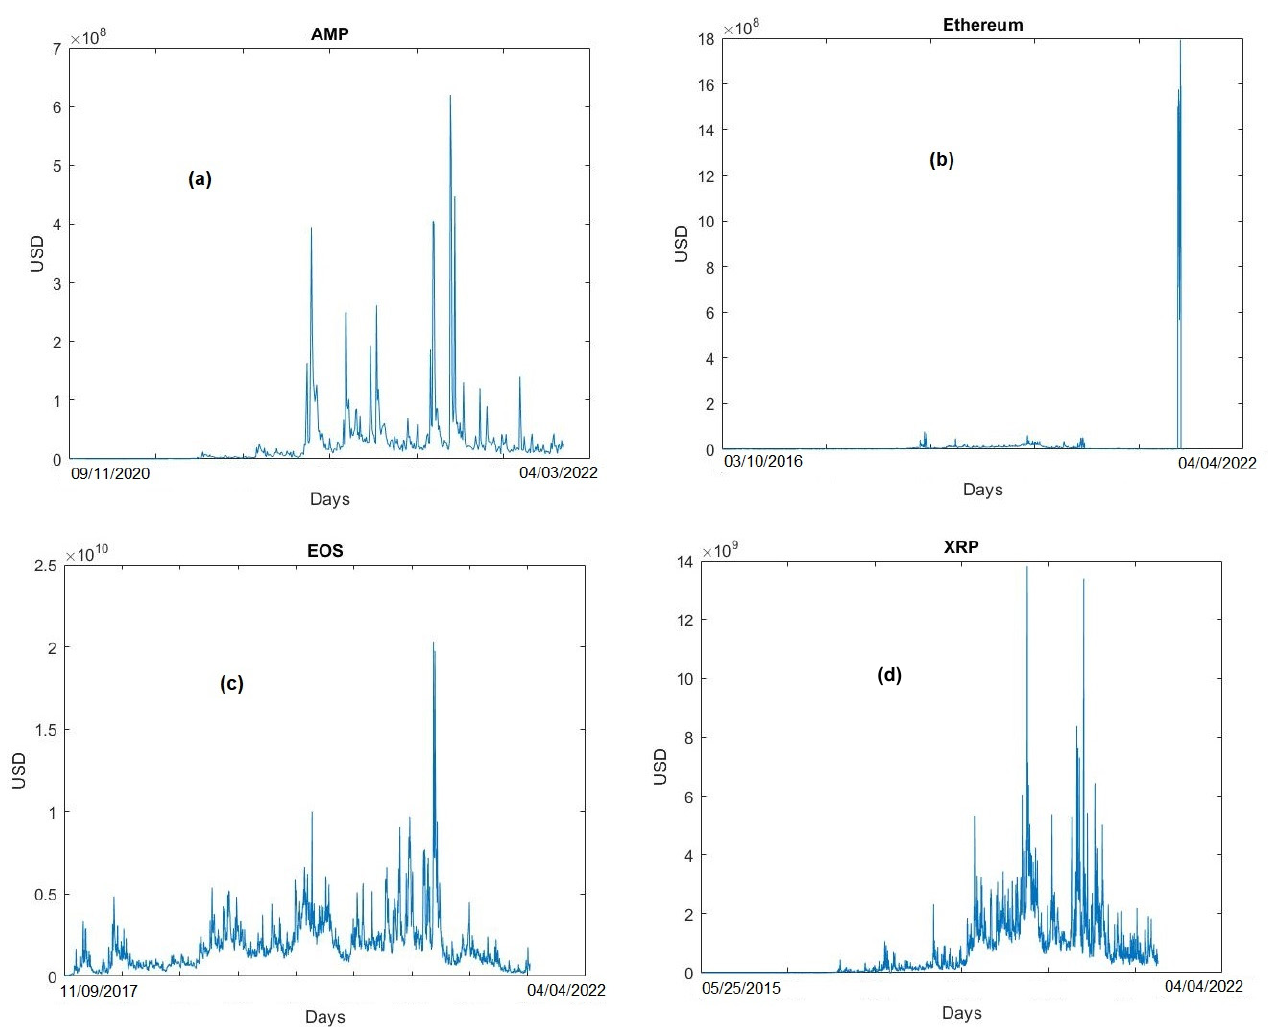
Figure 2. Cryptocurrency data sets: ( a ) AMP, ( b ) Ethereum, ( c ) EOS, and ( d ) XRP.